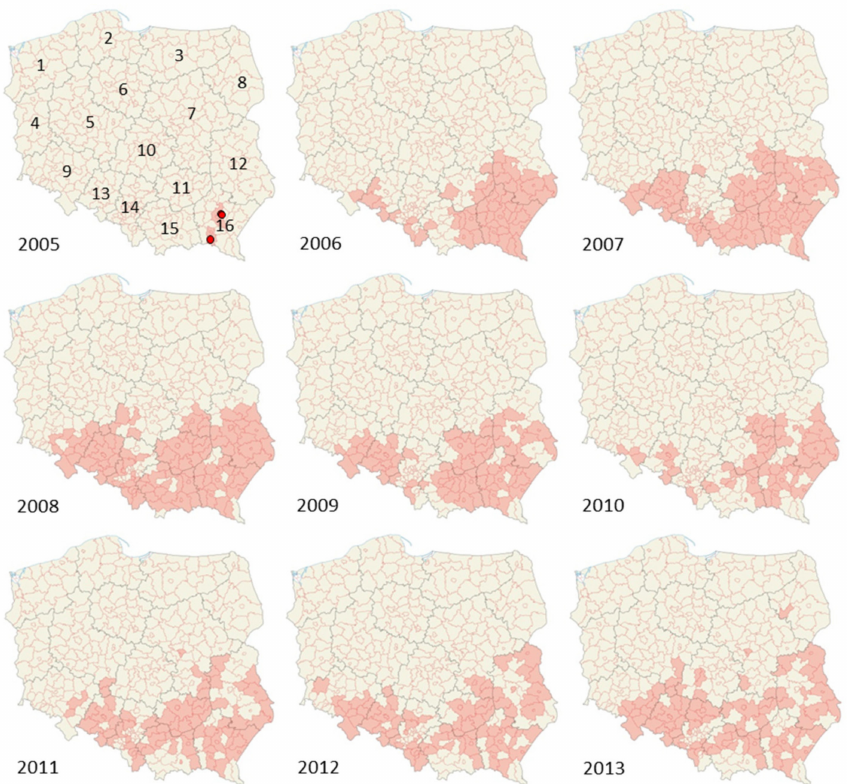
Figure 12. Stages of expansion of Diabrotica virgifera virgifera in Poland identified as part of the national monitoring of this species by the State Plant Health and Seed Inspection Service (SPHSIS) in 2005–2013 [34]-modified and SPHSIS archives. The red points indicate the first described localities of D. virgifera in Poland in 2005 [33]; 1–16: numbers assigned to individual voivodships; see Table 1. Cameraria ohridella . Horse chestnut- Aesculus hippocastanum is a tree initially found only in park and roadside plantings as an ornamental plant. Currently, it is also found in the wild almost all over Poland (Figure 13a) [43]. The horse chestnut pest, Horse-chestnut leaf miner- C. ohridella , was first recorded in Poland in 1998 in the Botanical Garden in Wojsławice, 50 km south of Wrocław (No.: 9) near the S8 clearway from the Czech border to Wrocław and on to Warsaw [35]. A year later, a mass appearance of Horse-chestnut leaf miner was found, and trees were heavily damaged in the country’s southern regions, in the vicinity of Cieszyn, Pszczyna, and Racib ó rz (No.: 14). These are towns located